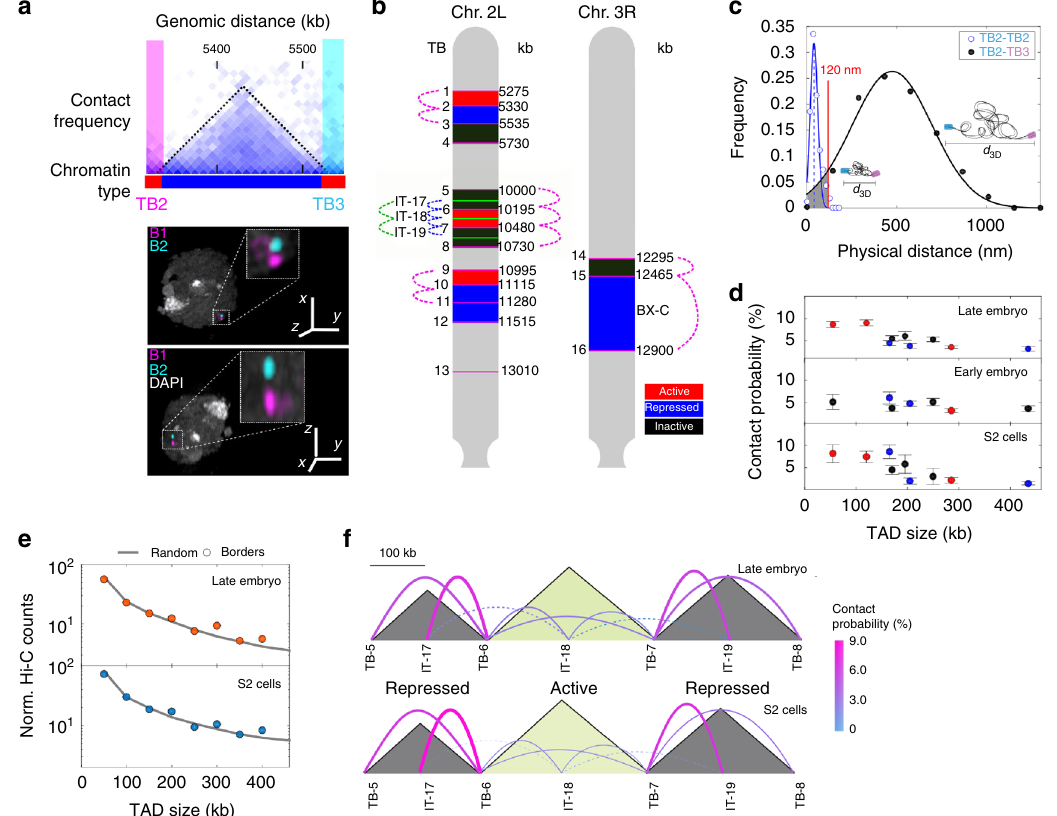
Fig. 1 TAD organization arises from modulation of stochasticity. a Top, region of Hi-C contact matrix of chromosome 2L. The black-dotted line demarcates a TAD and pink and cyan boxes represent the Oligopaint- labeled TAD borders (TB). Chromatin epigenetic state is indicated at the bottom using the color code of panel b . Bottom, representative three-color 3D-SIM image in two orientations. DAPI, TB2, and TB3 are shown in gray, pink, and cyan, respectively. Scale bar = 1 µ m for the main image. The inset displays 5× ampli fi cation of the selected region. b Oligopaint libraries in chromosomes 2L and 3R employed in this study (TB1-16 at TAD borders and IT17-19 within TADs). Colored boxes display the chromatin type of TADs as de fi ned in Supplementary Fig. 1a, b. Red: active, blue: repressed, and black: inactive. Dotted colored lines indicate the combinations of libraries measured. c 3D distance distributions between TB2 – TB2 and TB2 – TB3. The mean colocalization resolution, estimated from two-color labeling of a single border (40 nm, vertical blue dashed line). Blue and black solid lines represent Gaussian fi ttings. The absolute contact probability between libraries was obtained from the integral of the area of the Gaussian fi tting (shaded gray) below 120 nm (Supplementary Fig. 1e). N = 161 and 556 for TB2 – TB2 and TB2 – TB3, respectively, from more than three biological replicates. d Absolute contact probability between consecutive borders vs. genomic distance. Chromatin state of TADs is color coded as de fi ned in panel 1b. Error bars represent SEM. e Normalized Hi-C counts between consecutive TAD borders (circles) and random loci (solid gray line) as a function of genomic distance for S2 and late embryonic cells. Matrix resolution = 10 kb. Two biological replicates for each cell type were performed. f Schematic representation of contact probability between and within TADs (solid colored lines) for late embryo and S2 cells at the chromosomal region shaded in panel b . Sizes of TADs (gray-shaded triangles) are proportional to genomic length (scale bar on top). Chromatin type is indicated at the bottom. The thickness of the lines and color indicate the absolute contact probability. Dotted lines indicate inter-TAD contacts. Early embryo measurements are depicted in Supplementary Fig. 1k. Numbers of cells for each combination are provided in Supplementary Fig. 1f –